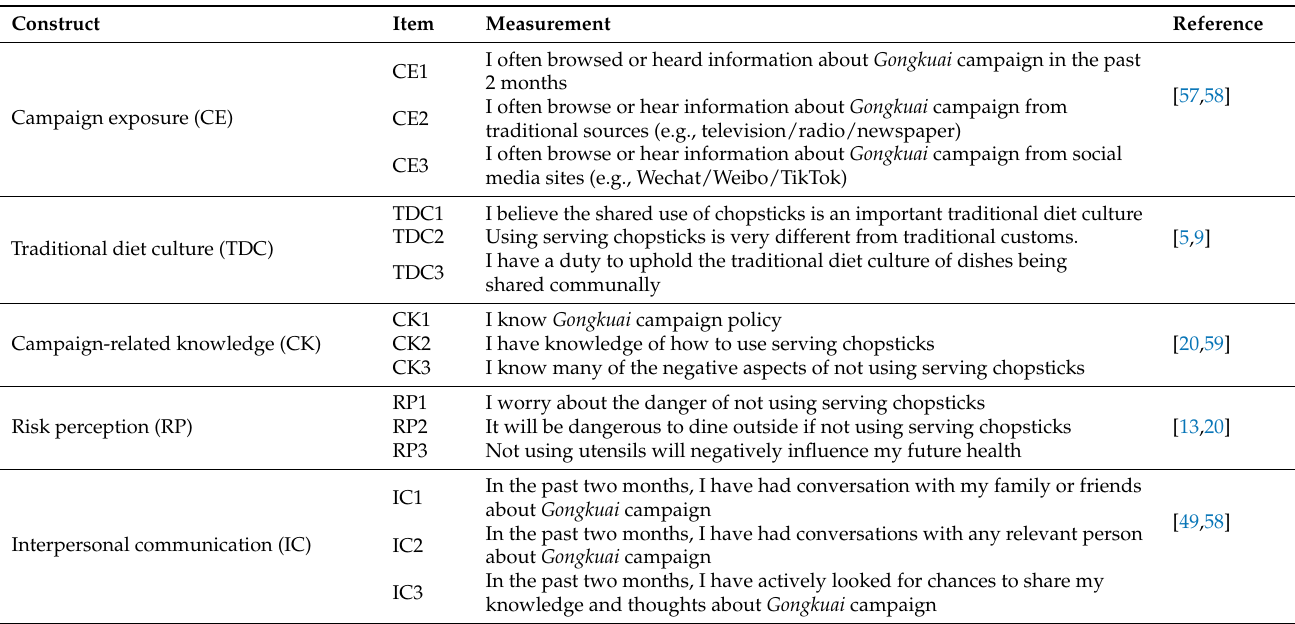
Table 2. Constructs and measurement items.